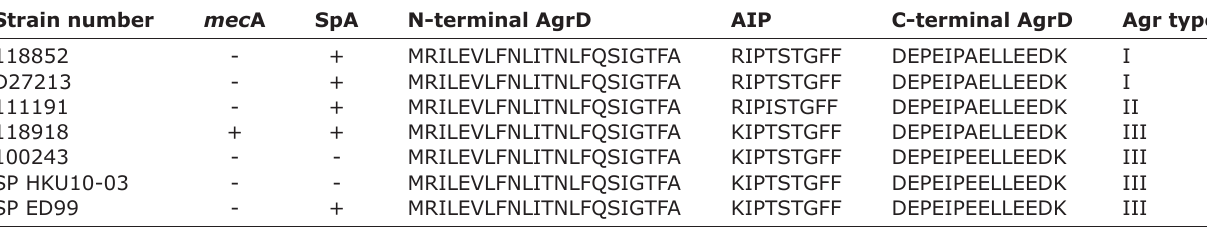
Table-2: Details of SP isolates, sequences of AgrD, and agr types. Strain